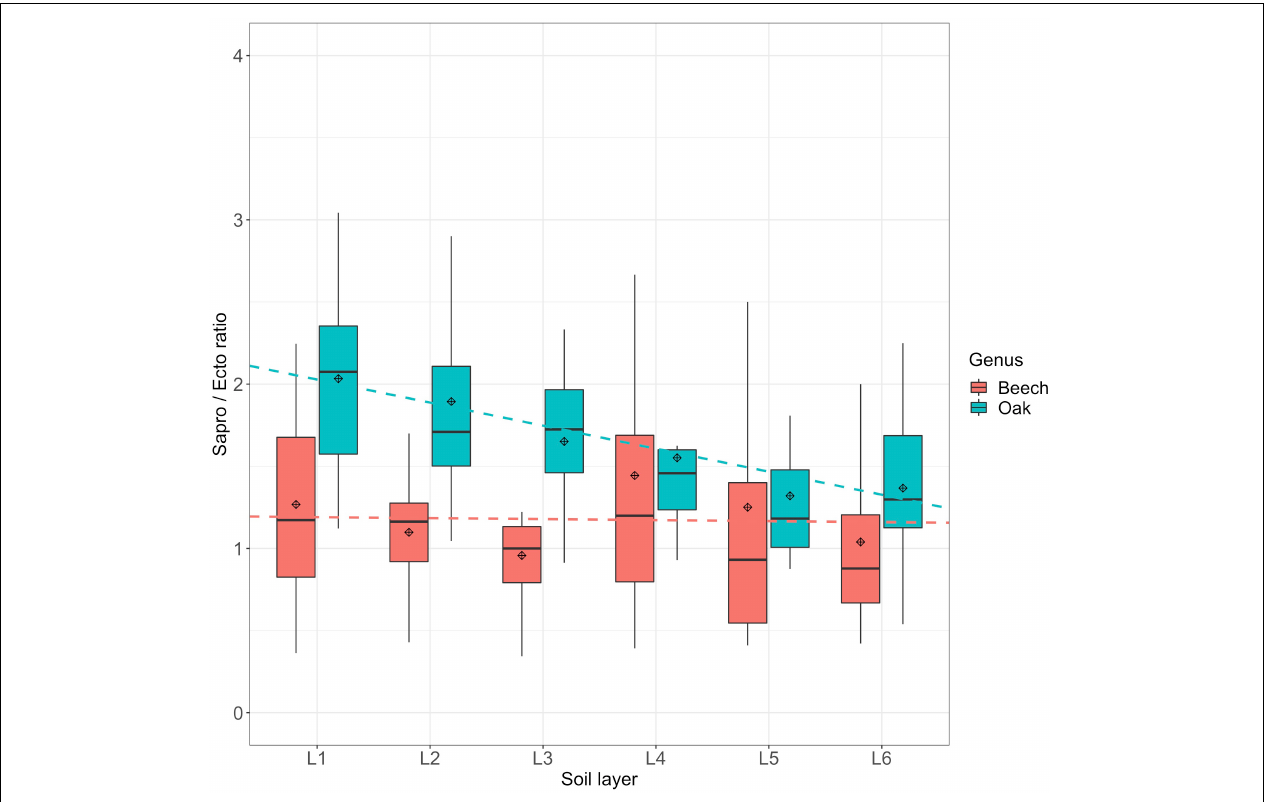
FIGURE 7 | Saprotrophs to ectomycorrhizal fungi ratio of relative abundances of fungi in soils and fine roots in the various soil layers (L1–L6) at beech and oak sites. Fungal functional guilds were analyzed by FUNGuild. Dashed lines have been drawn for better visualization. Soil layers: L1: 0–10 cm, L2: 15–25 cm, L3: 45–55 cm, L4: 75–85 cm, L5: 110–125 cm, L6: 140–155 cm.